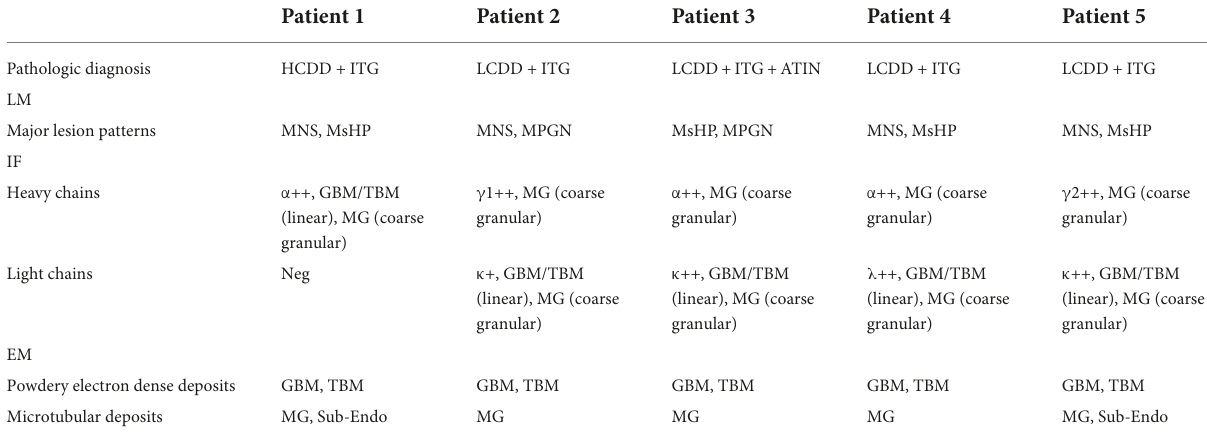
TABLE 2 Renal pathological